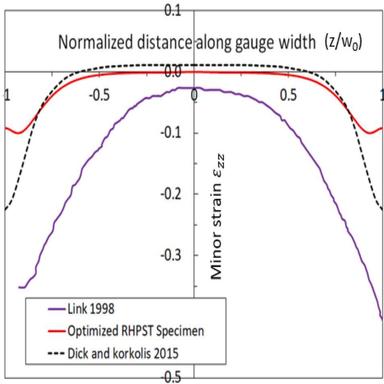
Comparison between the minor strain along the gauge section of the new proposed specimen (red solid line) and the specimens developed by and.